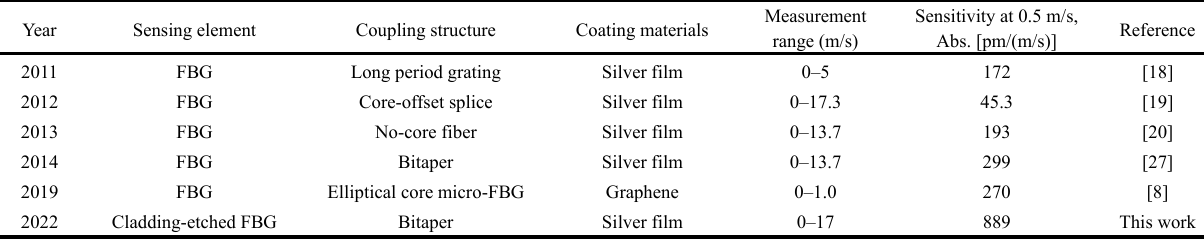
Table 1 Performance comparison of FBG hot-wire